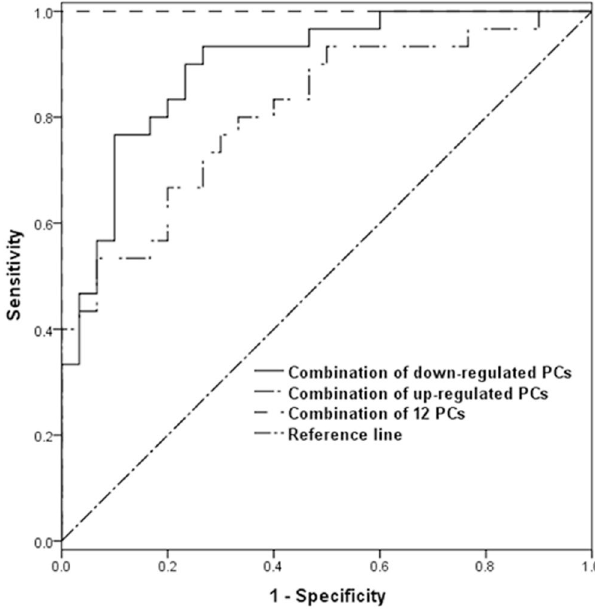
Figure 8. ROC curves of the combination of PCs that were altered between HC and early-stage NSCLC